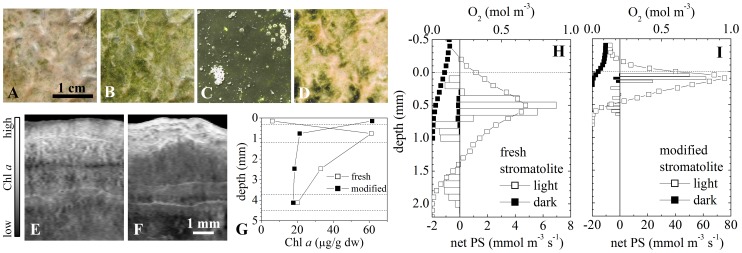
Effect of UV irradiation on the distribution and activity of cyanobateria in the stromatolites.(A–D) Appearance of the stromatolite surface under various light conditions: (A) full ambient light at 3500 masl, (B) after 1–2 hours of incubation in a shade at 3500 masl, (C) after 5 days of incubation at ambient light conditions with the UV light intensity reduced by about 30% (at 460 masl), (D) after 2–3 hours of exposure to artificial UV-B radiation at 460 masl. Note that because of the extremely dark-green appearance of the surface in panel C (reflectance <1%), the brightness of the shown image was increased 5-fold. (E–G) Vertical distributions of Chl a in the stromatolite obtained by hyperspectral imaging and HPLC. Panels E and F correspond to samples shown in panels A and B, while open and closed symbols in panel G correspond to samples shown in panels A and C, respectively. (H–I) Steady state profiles of oxygen and of the volumetric rates of net photosynthesis (net PS) in the freshly collected (shown in A) and modified (shown in C) stromatolite. Shown are profiles measured at incident PAR intensities of 600 µmol photons m−2 s−1 (open symbols and bars) and in the dark (filled symbols and bars). Note the 10-fold difference in the scaling of the net PS axis.